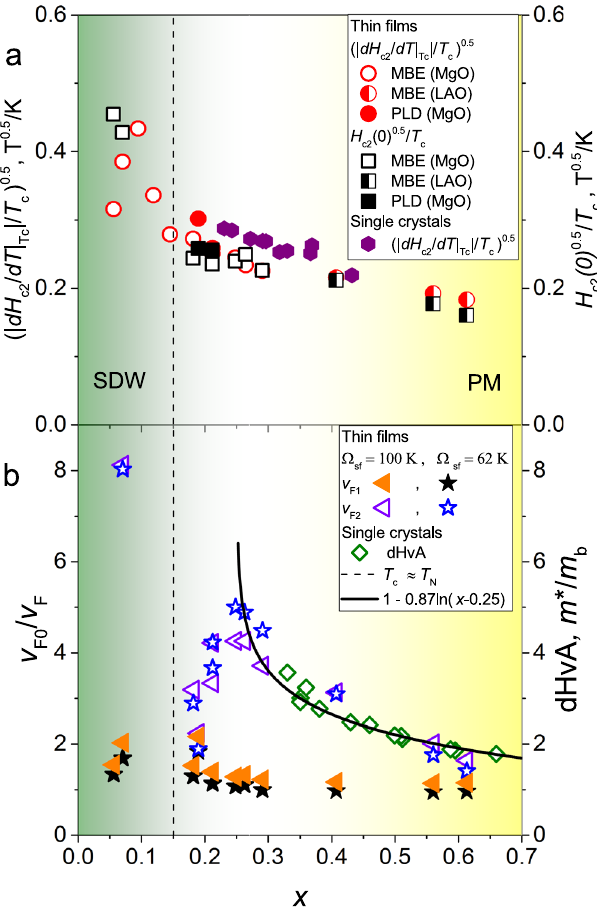
0 5 at T Figure 3. (( a ) left axis) The normalized slope of the upper critical field ′ . H T ( / ) c and (( a ) right axis) the c2 c normalized upper critical field ( H c2 ) 0.5 / T c extrapolated to T = 0 K using the fits shown in Fig. 2 versus the P-doping level x . Both these quantities are related to the charge carrier effective mass m * as discussed in the text. The single - crystal data are taken from ref. 21. (( b ) Left axis) The inversed normalized Fermi velocities v F0 / v F1 and v F0 / v F2 in a two-band model are obtained from the fits shown in Fig. 2. (( b ) Right axis) The normalized effective quasiparticle mass m * / m b obtained from the dHvA data 7, 16 . The v F0 values are chosen to fit dHvA data, v F0 = 1.3 · 10 7 and 1.1 · 10 7 cm s − 1 for Ω sf = 100 K and 62 K, respectively. All the data of the thin films grown on LAO, and single- crystal data are shifted by Δ x = − 0.05 to meet the QCP of the thin films grown on MgO according to Fig. 1b. The solid line is a fit to a phenomenological divergence of the effective mass near a QCP ∝ ∝ + . − ⁎ v m x x 1/ 1 0 87ln( ) , refs 8 and 13, with x c = 0.25. The dashed line denotes approximately the P F1 c doping value where T c = T N